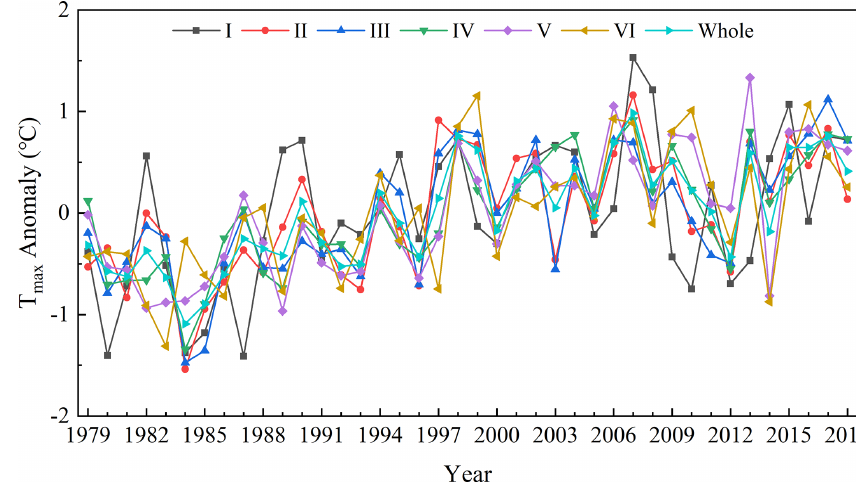
Figure 9. Inter-annual changes of T max anomalies in six regions of China during